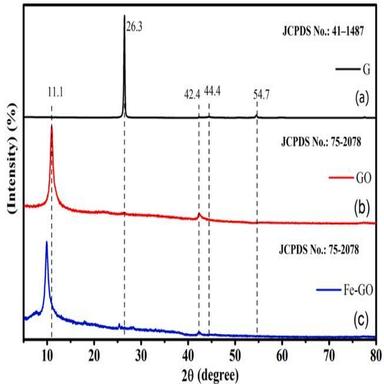
XRD Profiles of Graphite (G), Graphene Oxide (GO), and the Fe-GO Nanocomposite.